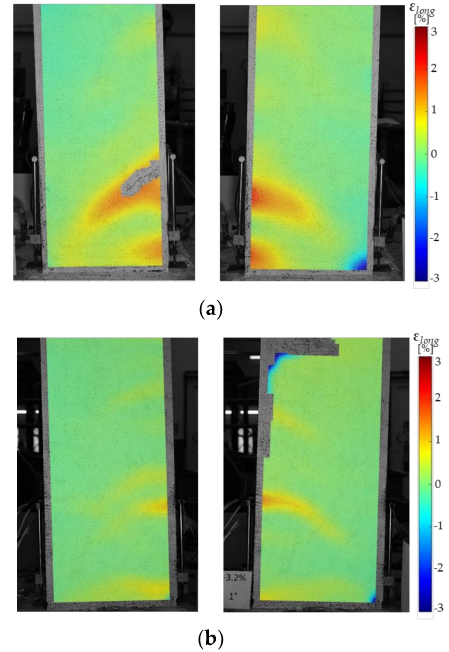
Figure 16. Strain fields for specimen CL_FRCC during pre-damage ( a ) and repaired phase ( b